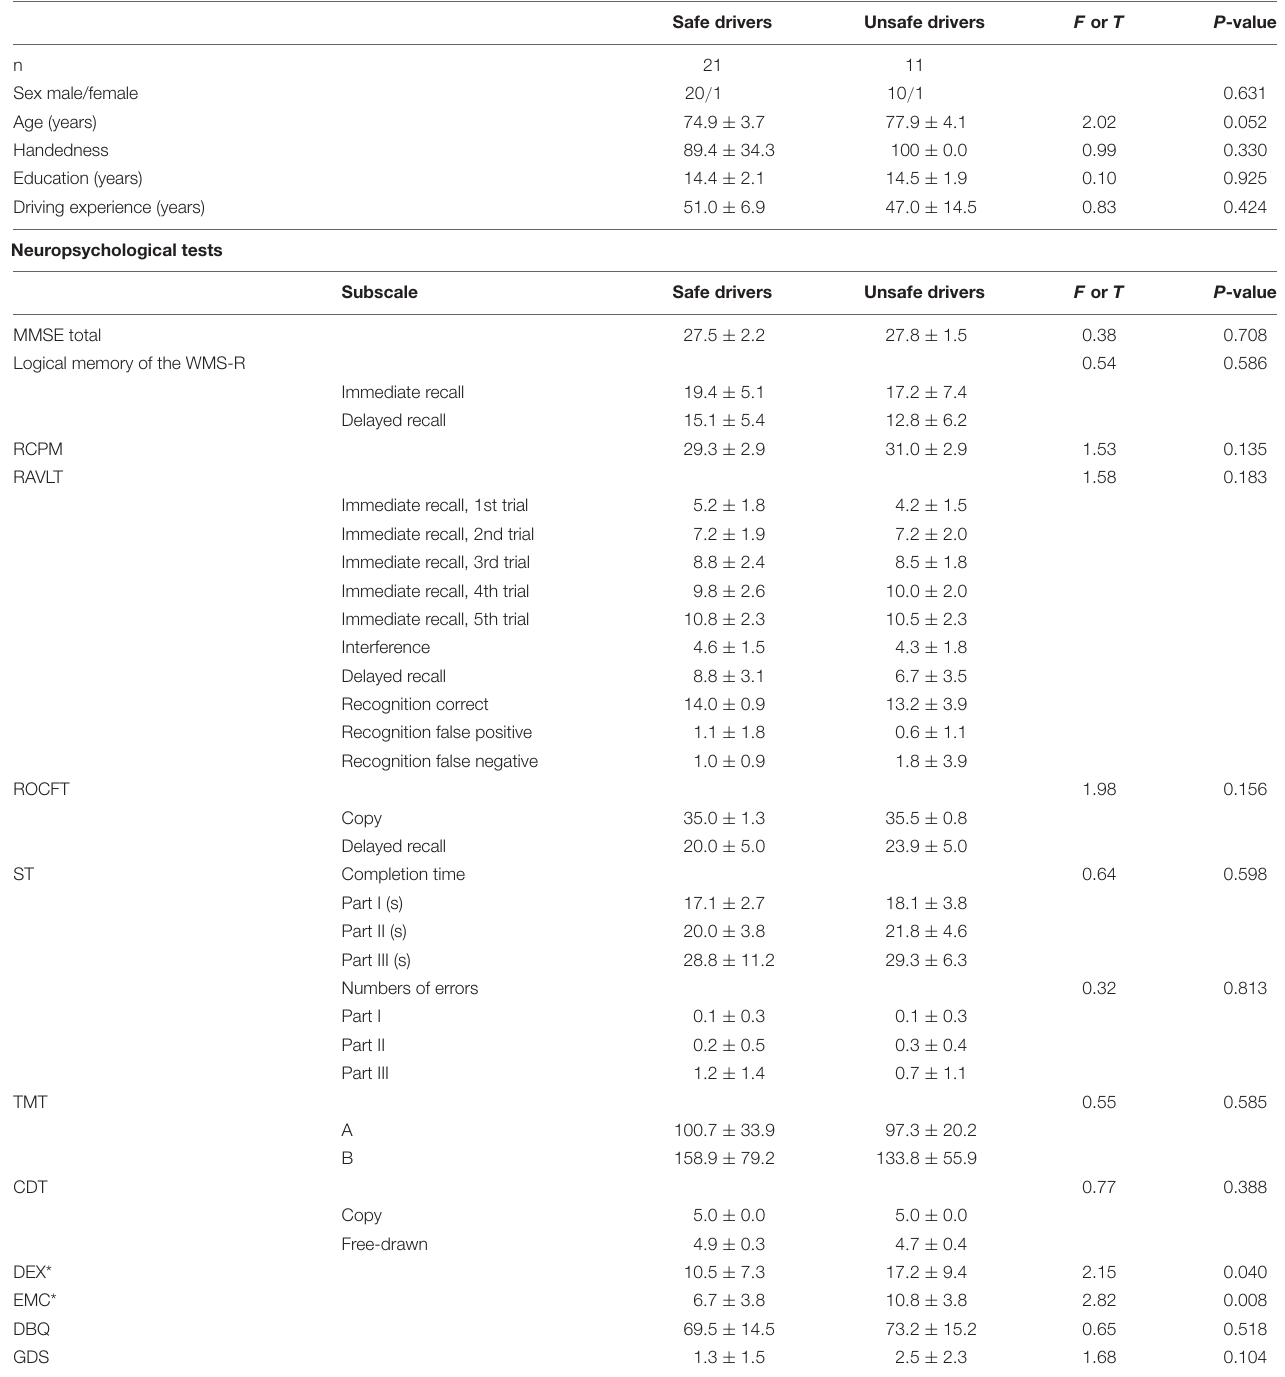
TABLE 1 | Demographics and results of neuropsychological and functional visual acuity test. Demographic